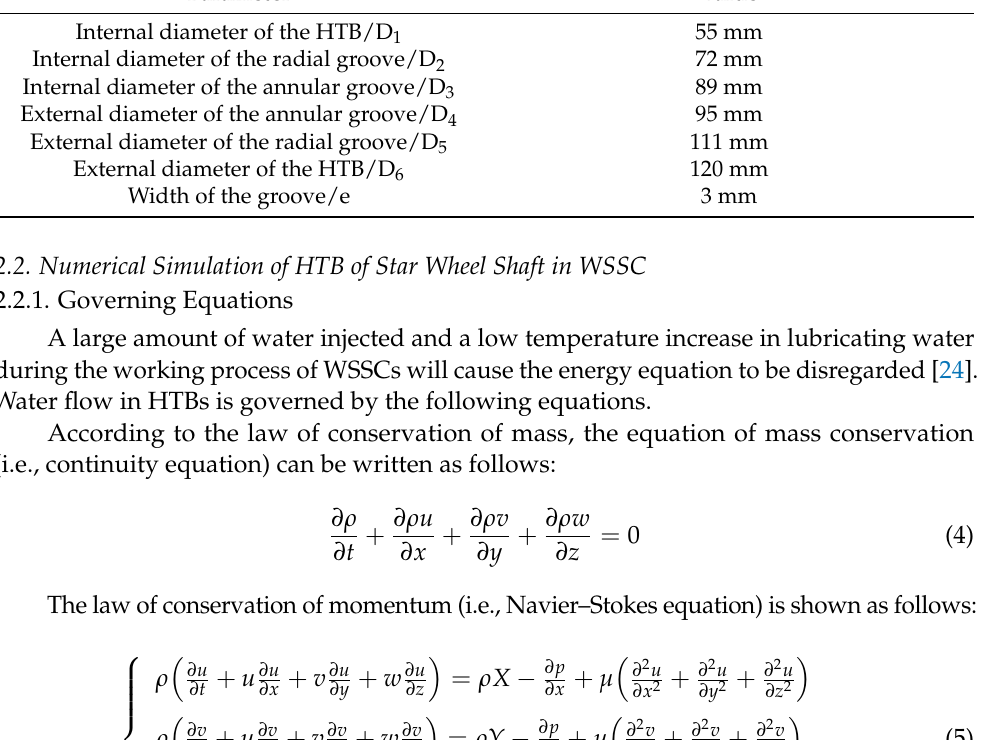
Parameter Value